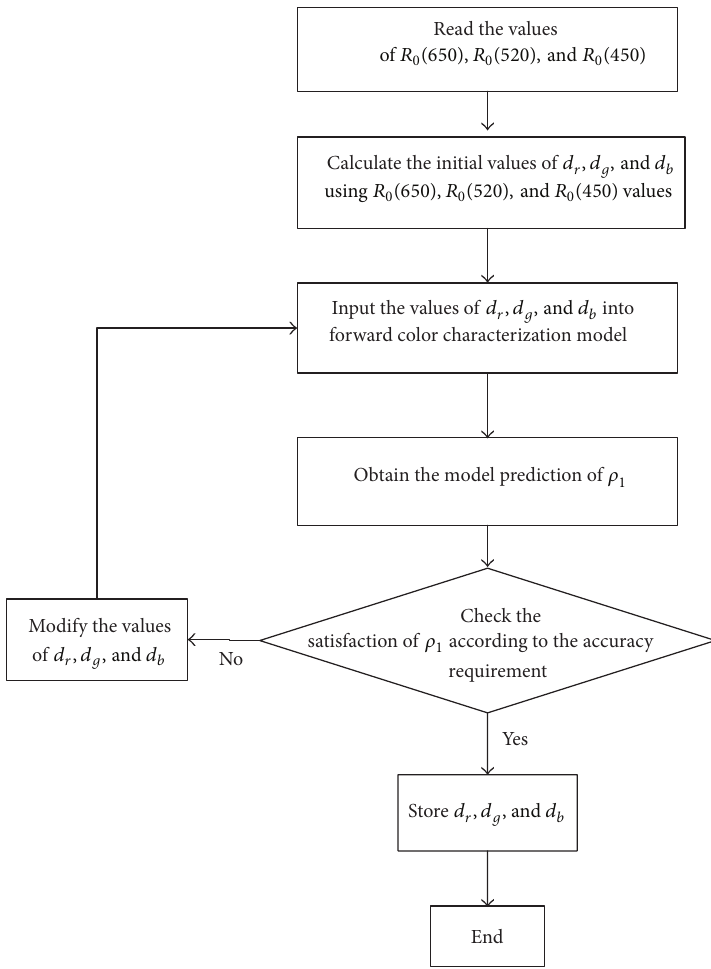
Figure 3: Flowchart of backward color-characteristic model based on forward